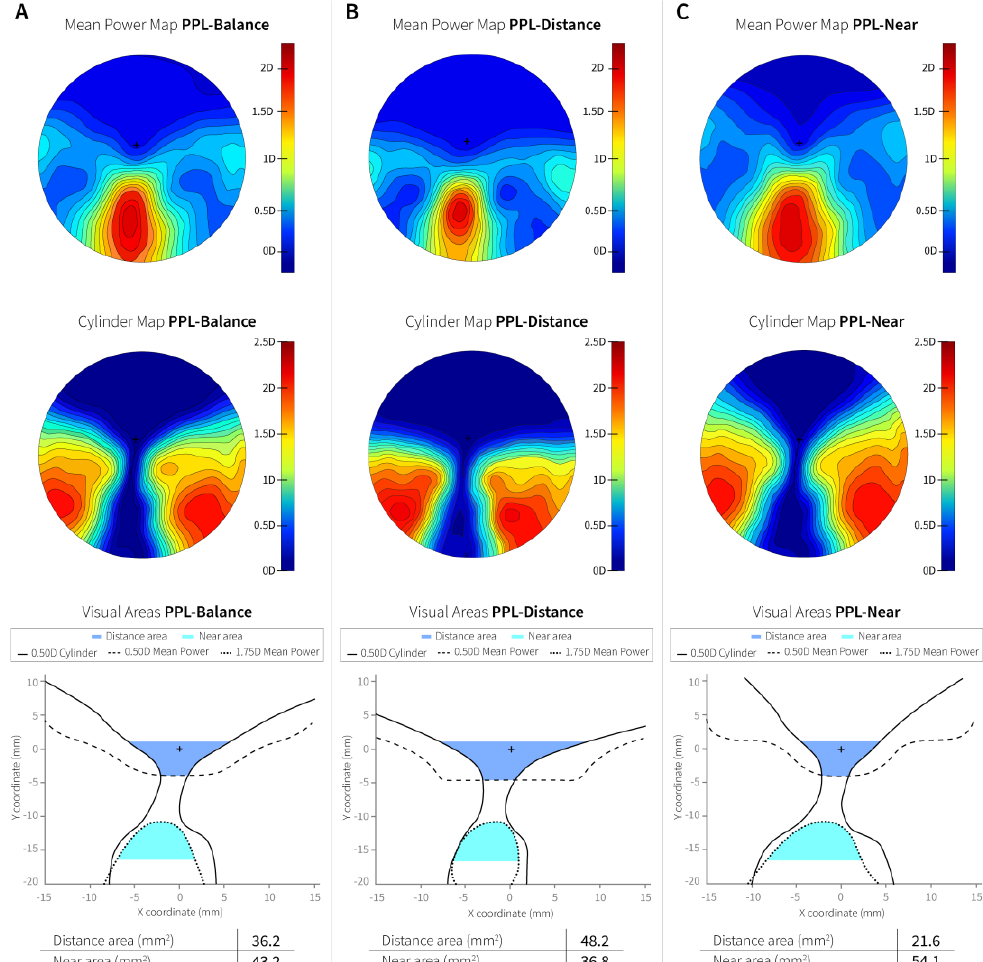
Figure 1. Mean power, cylinder power maps distribution, and visual areas according to Sheedy’s criteria [6] for a Plano prescription, addition 2D with default parameters. ( A ) PPL-Balance. ( B ) PPL- Distance. ( C ) PPL-Near. Reprinted with permission from Ref. [30]. 2023, Concepcion-Grande et